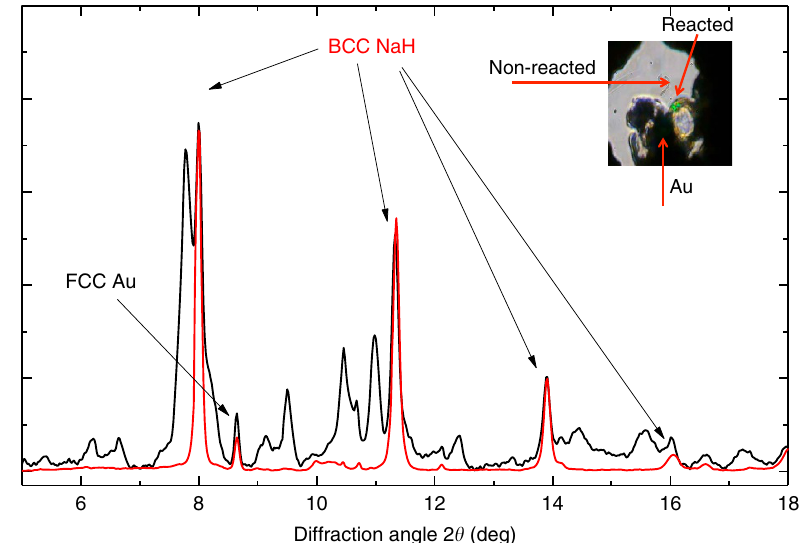
Figure 3 | Structural information from XRD measurements. XRD raw pattern (black) of the reacted area of the sample at 50GPa, containing Bragg peaks from BCC NaH and FCC Au, which are indicated by arrows. The red XRD pattern is from a non-reacted area of the sample containing only BCC NaH and FCC Au. The perfect match of the position of the NaH peaks between the reacted and the non-reacted area justifies our argument about the origin of these peaks. The inset shows a reacted sample, dark sample in a gasket hole is Au þ Na. The transparent part is NaH þ H 2 , the smaller dark circle with a green laser spot is a reacted area. The darker colour of the reacted area is compatible with a reduced bandgap ( B 2eV) obtained in the DFTcalculations (Fig. 6).